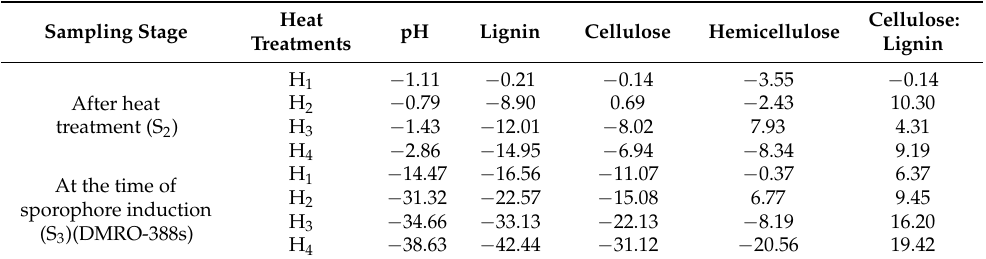
Table 3. Percentage of change in the lignocellulosic content of the sawdust substrate due to heat treatment and solid-state